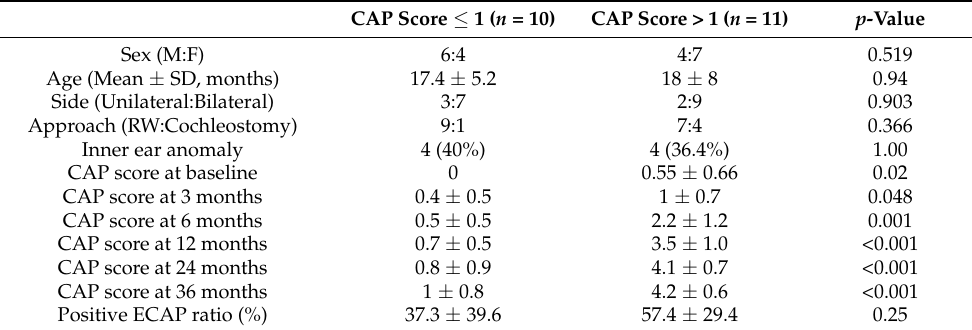
Figure 3. Longitudinal changes in CAP scores according to CAP score at 1 year postoperation. Patients were subclassified into four groups based on CAP scores at 1 year postoperation and depicted individual postoperative auditory performance. CAP, Category of Auditory Performance; CI, cochlear implant; Preop, preoperative; M, postoperative months. Table 2. Comparison of clinical profiles between patients with CAP score ≤ 1 versus patients with CAP score >1 at 1 year postoperation.